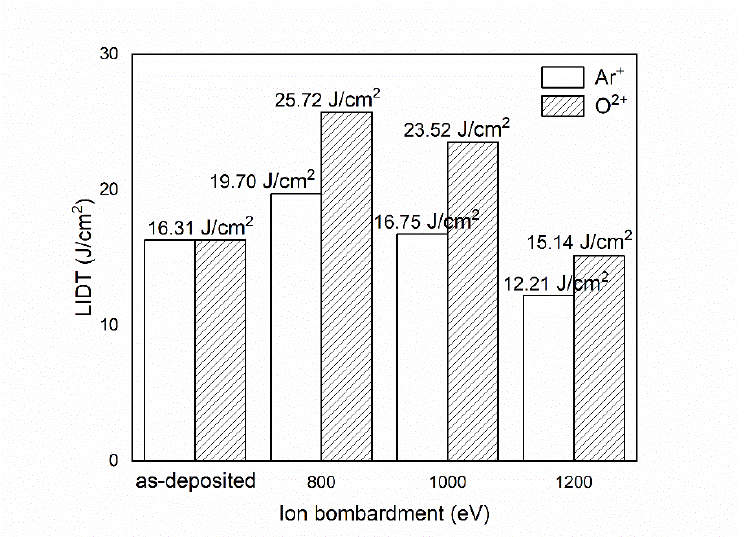
Figure 6. Laser damage threshold of HfO 2 film irradiated at various ion energies under Ar and O 2 atmosphere.